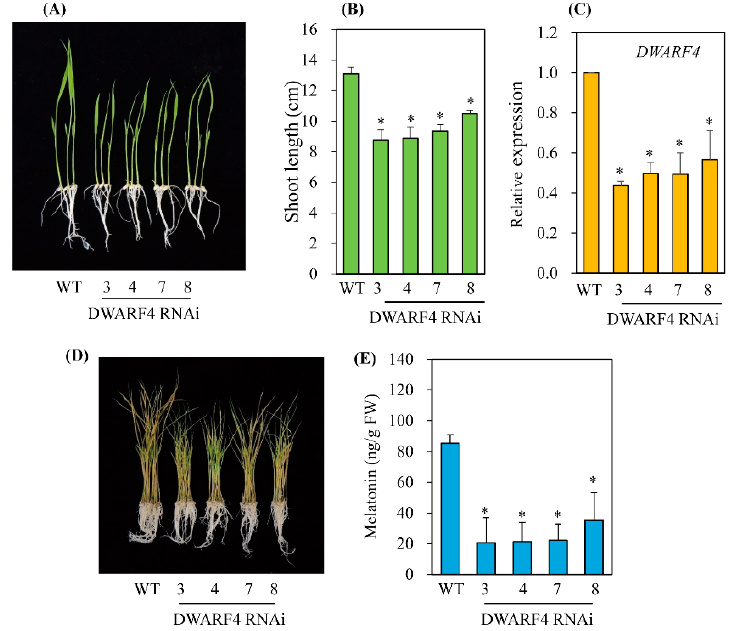
Figure 4. Generation of DWARF4 -suppressed transgenic rice plants. ( A ) Phenotypes of 7-day-old wild-type (WT) and DWARF4 RNAi transgenic (T 2 ) rice seedlings. ( B ) Shoot length measurement. ( C ) qRT-PCR analyses of WT and transgenic (T 2 ) lines. ( D ) Phenotypes of 7-day-old rice seedling after cadmium treatment. ( E ) Melatonin levels of WT and transgenic lines. Seven-day-old rice seedlings were challenged with 0.5 mM cadmium for 3 days for quantification of melatonin. Asterisks (*) indicate significant differences from the wild type ( p < 0.05), as determined by Tukey’s HSD post-hoc tests.